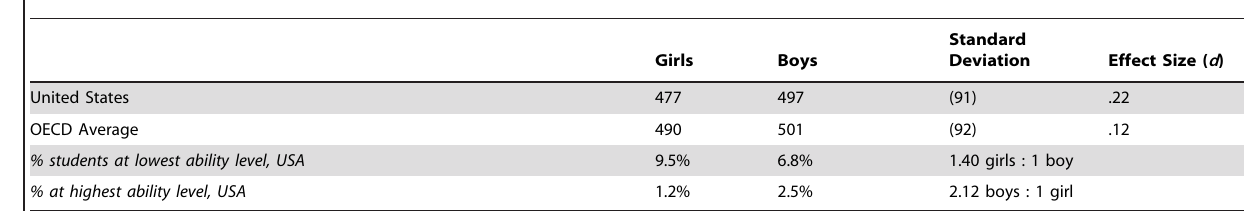
Table 6. Mean Mathematical Ability for Girls and Boys for the USA and OECD